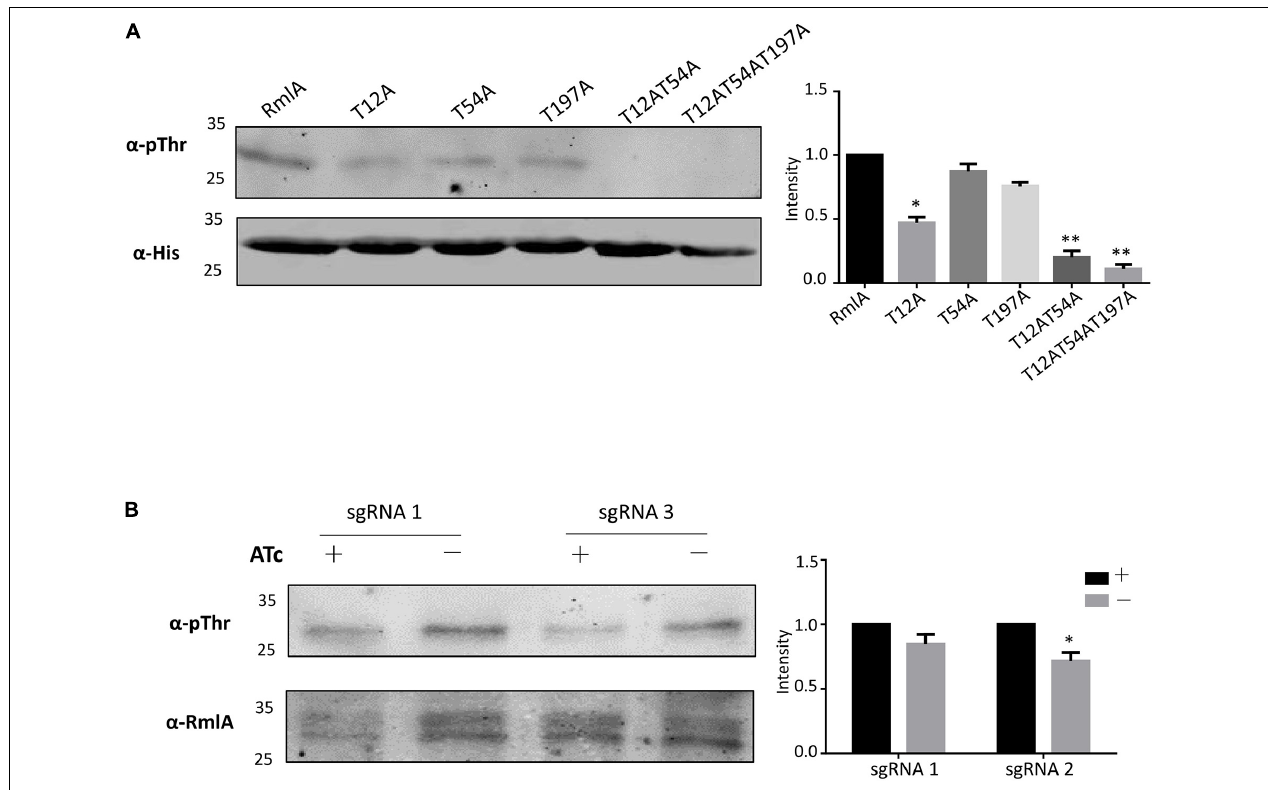
FIGURE 2 | RmlA is mainly phosphorylated by PknB with T12 site. (A) Phosphorylation of RmlA and mutants in M. smegmatis . The WT and mutants of rmlA genes were cloned into pMV261 with His tag and incorporated into M. smegmatis . The proteins were purified with Ni 2 + agarose beads. With Western blotting, phosphorylated signals were detected with the antithreonine phosphorylation antibody. The experiment was performed in triplicates ( n = 3). Error bars indicate standard error of mean. Asterisk indicates significant difference ( P < 0.05). (B) Phosphorylation of RmlA with the pknB -KD in M. smegmatis . The RmlA protein was purified from strains with sgRNA 1 and sgRNA 3 targeting, which have strong repression of PknB expression, using anti-RmlA antibody, and pull-down with protein G beads. Through Western blotting, phosphorylated signals were detected with the antithreonine phosphorylation antibody. The experiment was performed in triplicates ( n = 3). Error bars indicate standard error of mean. Asterisk indicates significant difference ( P <